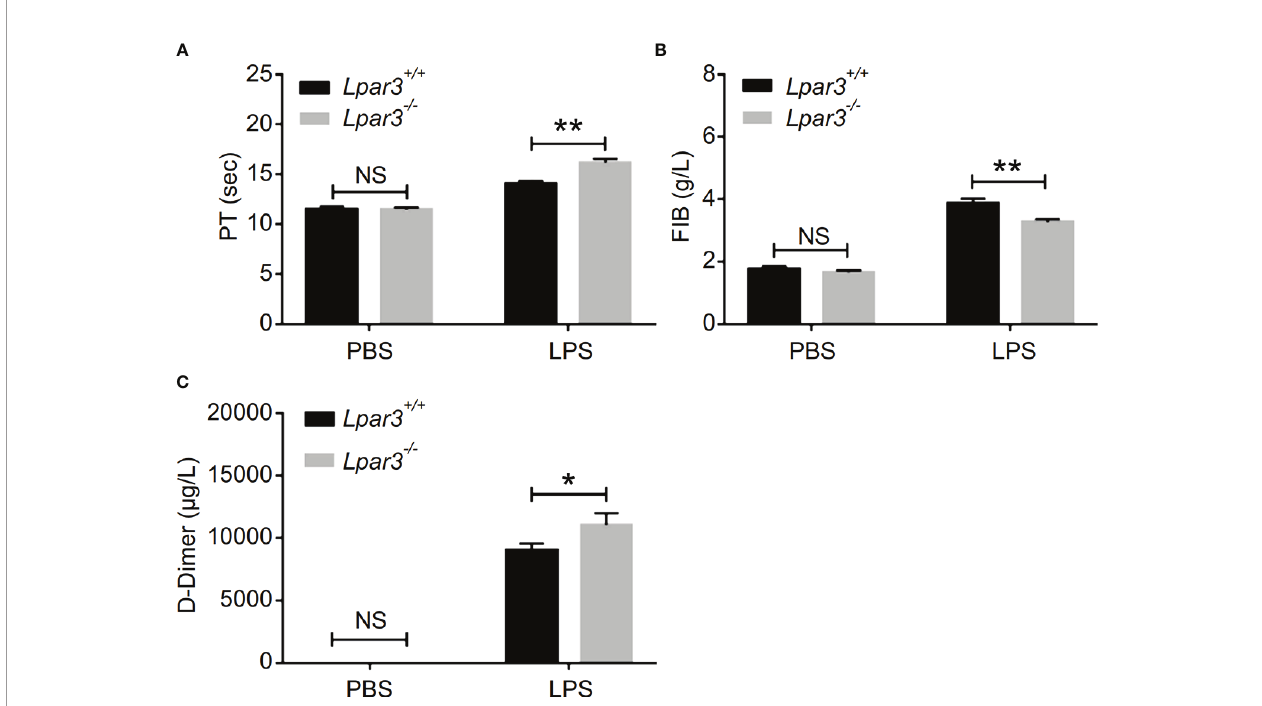
FIGURE 2 | LPA 3 de fi ciency exacerbates coagulation abnormalities and thrombosis in mice with sepsis. (A – C) The circulating levels of coagulation markers in the mice after LPS injection. Lpar3 -/- septic mice lengthened the PT, contained less FIB and more D-dimers compared with WT septic mice (n = 8 for each group); *P < 0.05, **P < 0.01. NS, no signi fi cance. LPA 3 , lysophosphatidic acid receptor 3; WT, wild-type; LPS, lipopolysaccharide; PT, plasma prothrombin time; FIB, fi